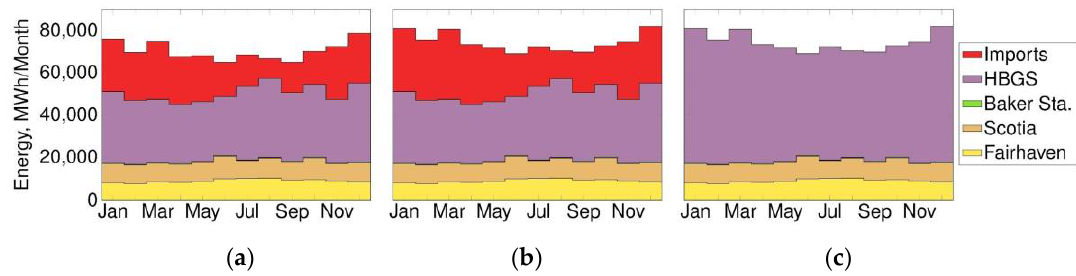
Figure 11. Historic generation in Humboldt County coupled with imports required to meet 2030 projected load: ( a ) based on 2017–2018 loads and generation; ( b ) based on 2017–2018 generation and 2030 loads; ( c ) based on 2030 loads with imports replaced by HBGS. Note that Baker Station, a small hydroelectric facility, provides a small amount of energy relative to the other generators.